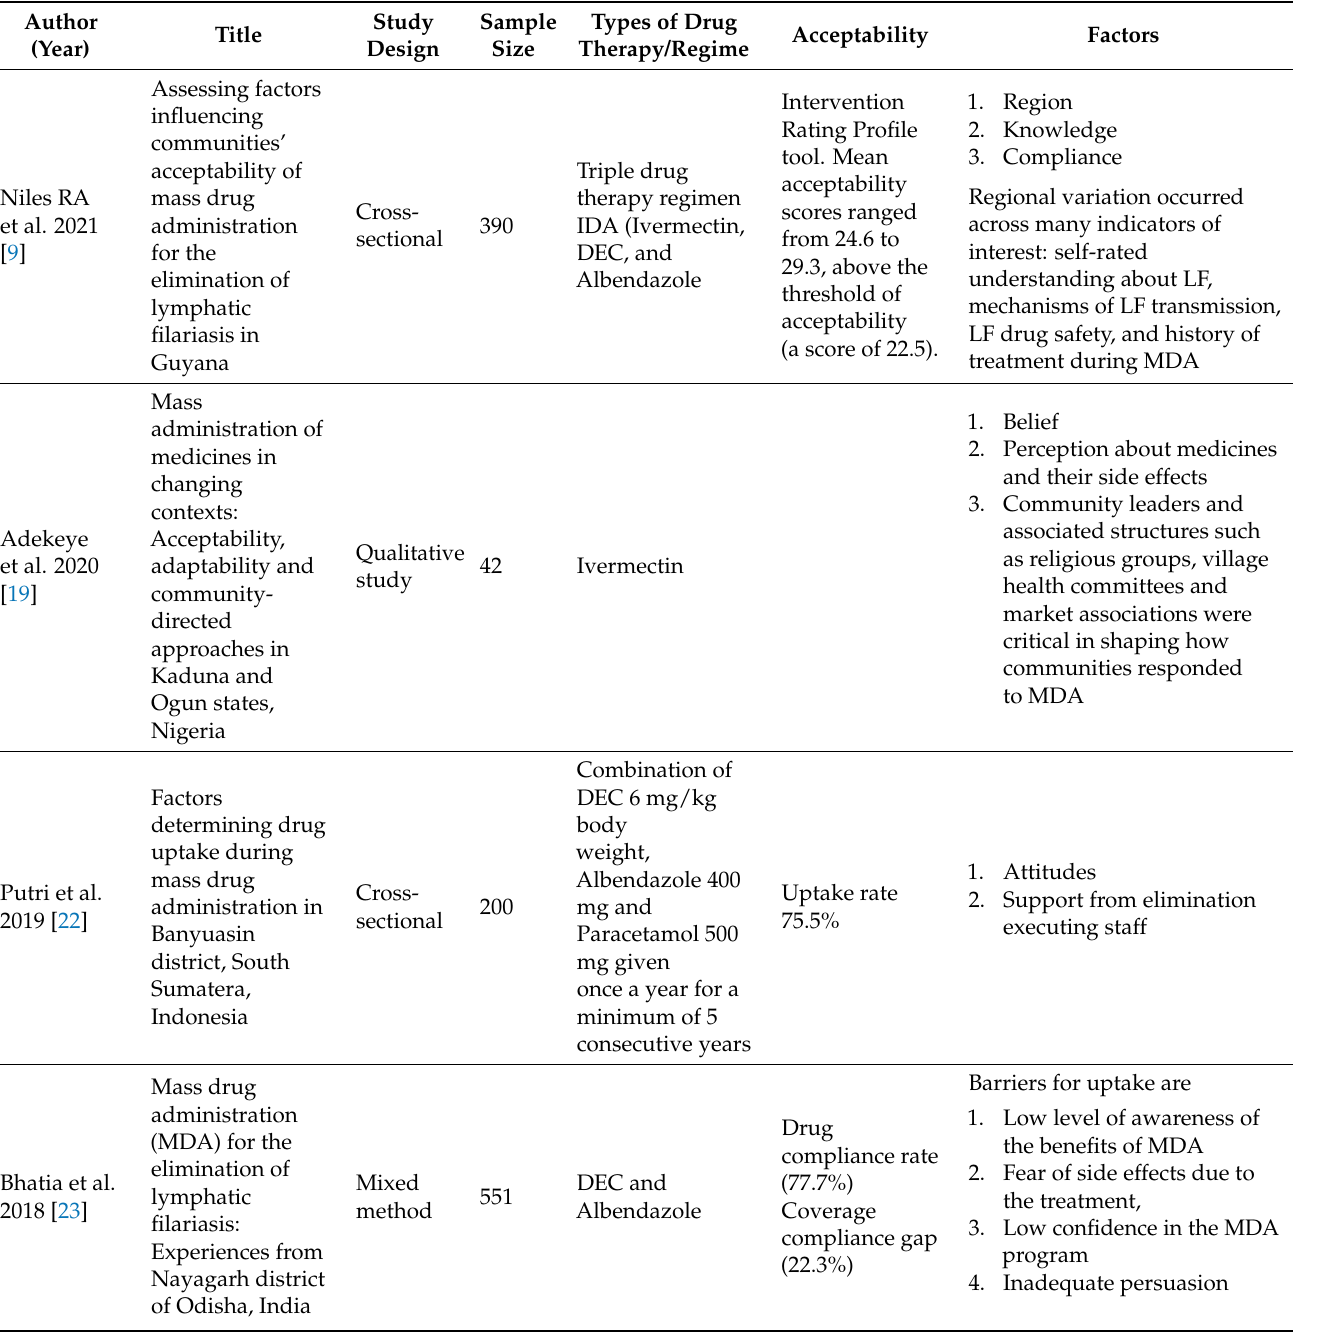
Table 2. Summary of accepted